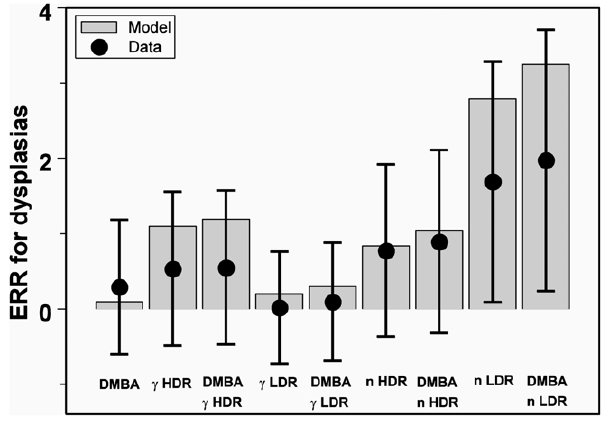
Figure 4. The data and model predictions for dysplasia ERR after exposure to c -rays, neutrons and/or DMBA. Legend: DMBA=2.5 m g of DMBA; c =0.25 Gy of c -rays; n=0.025 Gy of neutrons; HDR=high dose rate; LDR=low dose rate.